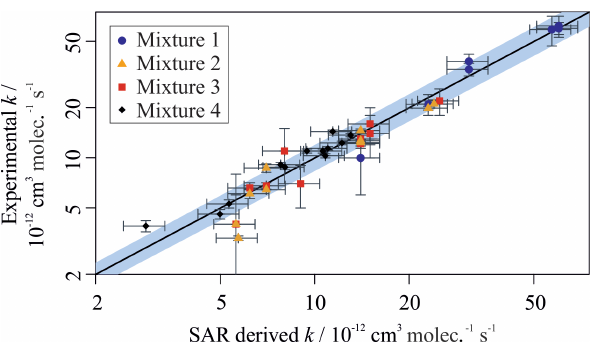
Figure 6. Experimentally derived (data points; see Tables 2 and 3) and estimated SAR-derived (line; see Jenkin et al., 2018a) k val- ues for the reactions between OH and a homologous series of n - alkylbenzenes with different numbers of carbon atoms in the alkyl chain. Data from this, and other multivariate relative rate studies, are shown in